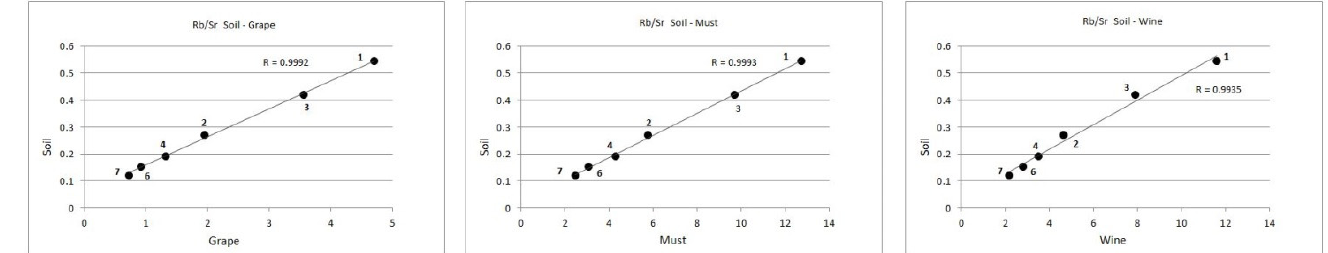
Figure 14. Analysis of the Rb/Sr isotope ratios measured in soils, grapes, musts and wines. The relationship between the Rb/Sr ratios remains constant in the vineyards and this result is maintained regularly in the different correlations analysed (R > 0.99; p < 0.001). This confirms a precise link between each vineyard and its oenological products. The numbers in the figures specify the vineyards. The V5 outlier was excluded from the statistical analysis. (see Table S5 in the supplementary material).